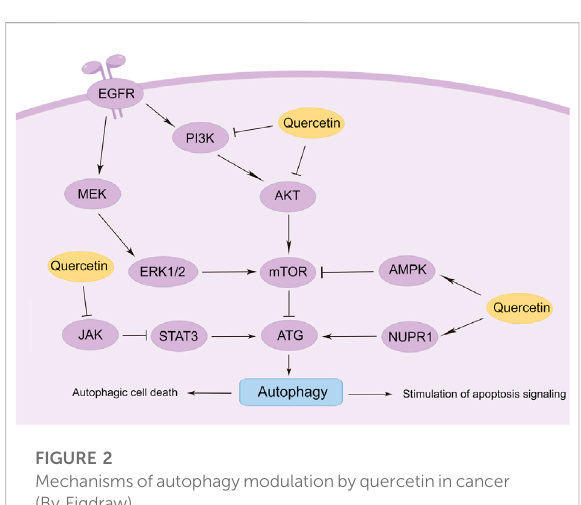
FIGURE 2 Mechanismsofautophagymodulationbyquercetinincancer (By